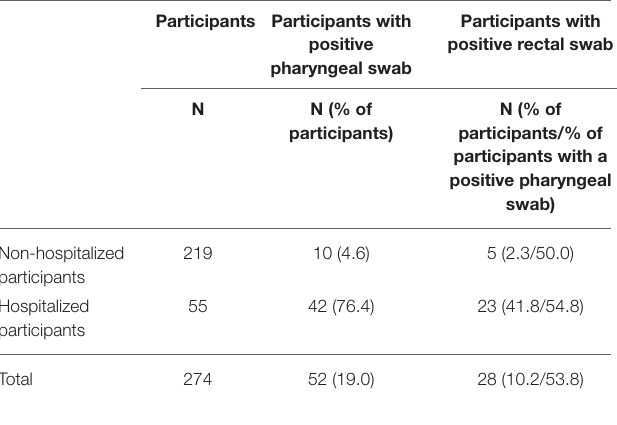
TABLE 1 | Outline of the participants in the